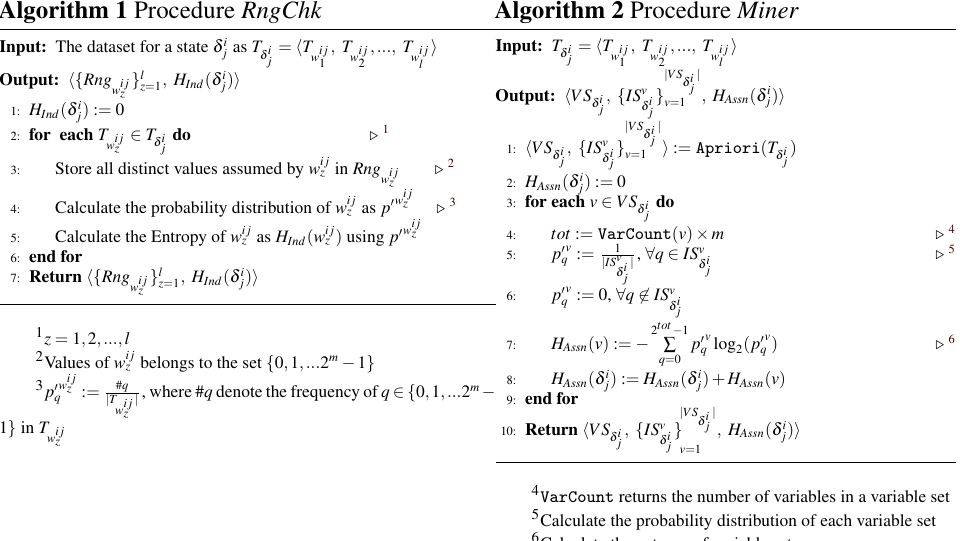
Algorithm 1 Procedure RngChk Algorithm 2 Procedure